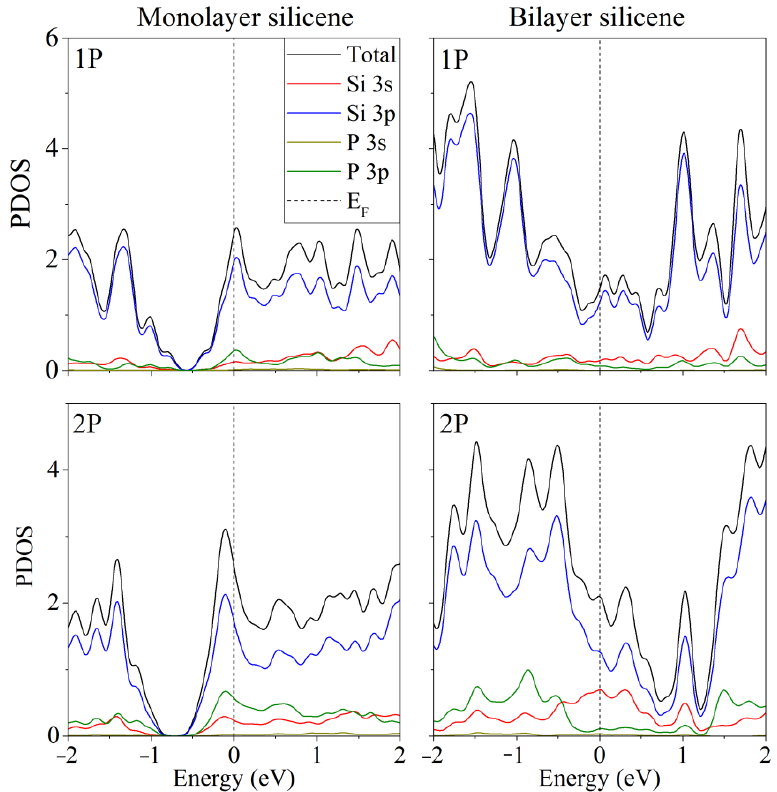
Figure 2. Partial spectra of electronic states of one- and two-layer silicene obtained by the replacement of 1 or 2 silicon atoms by phosphorus. Reprinted with permission from Ref. [48]. 2020, Springer.